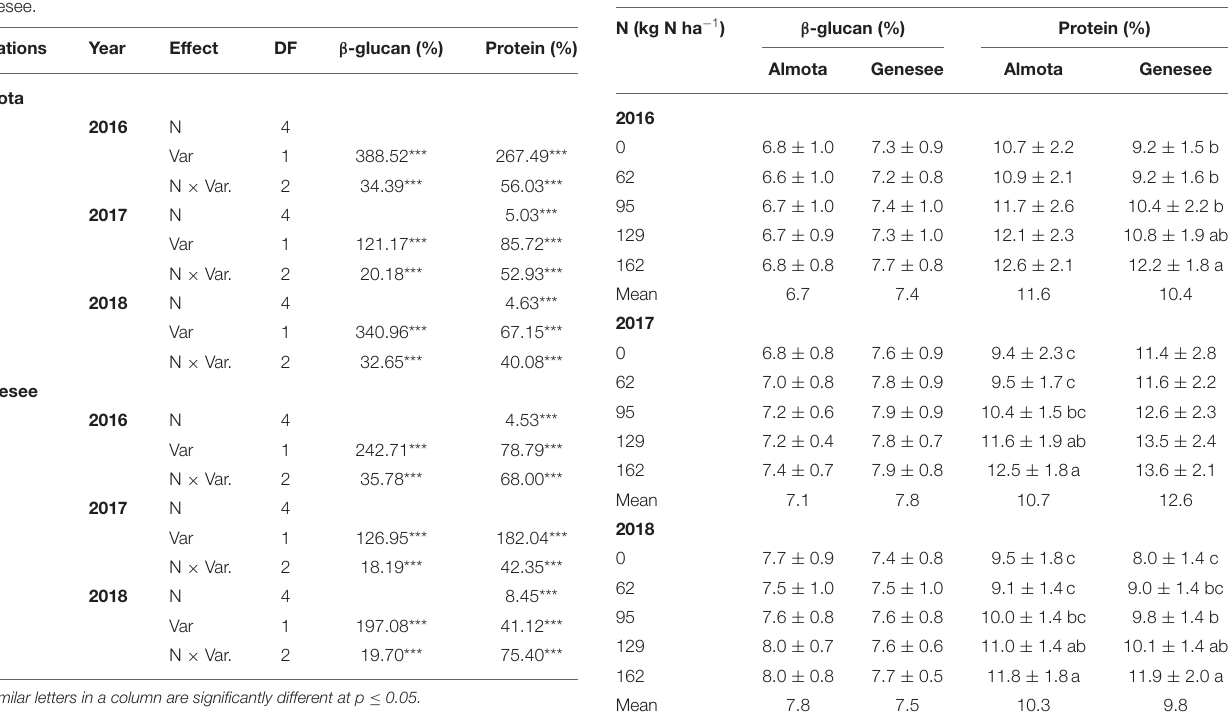
TABLE 2 | Mean data across six site-years for the effect of N rates on β -glucan and protein.